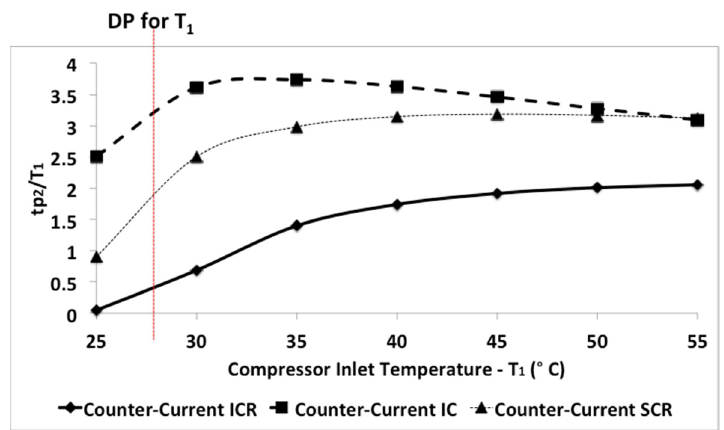
Figure 10. Comparison of Heat Sink Outlet Temperature for the Counter ‐ Current Precooler. The heat sink outlet temperature is normalised by the respective cycle/compressor inlet temperatures.